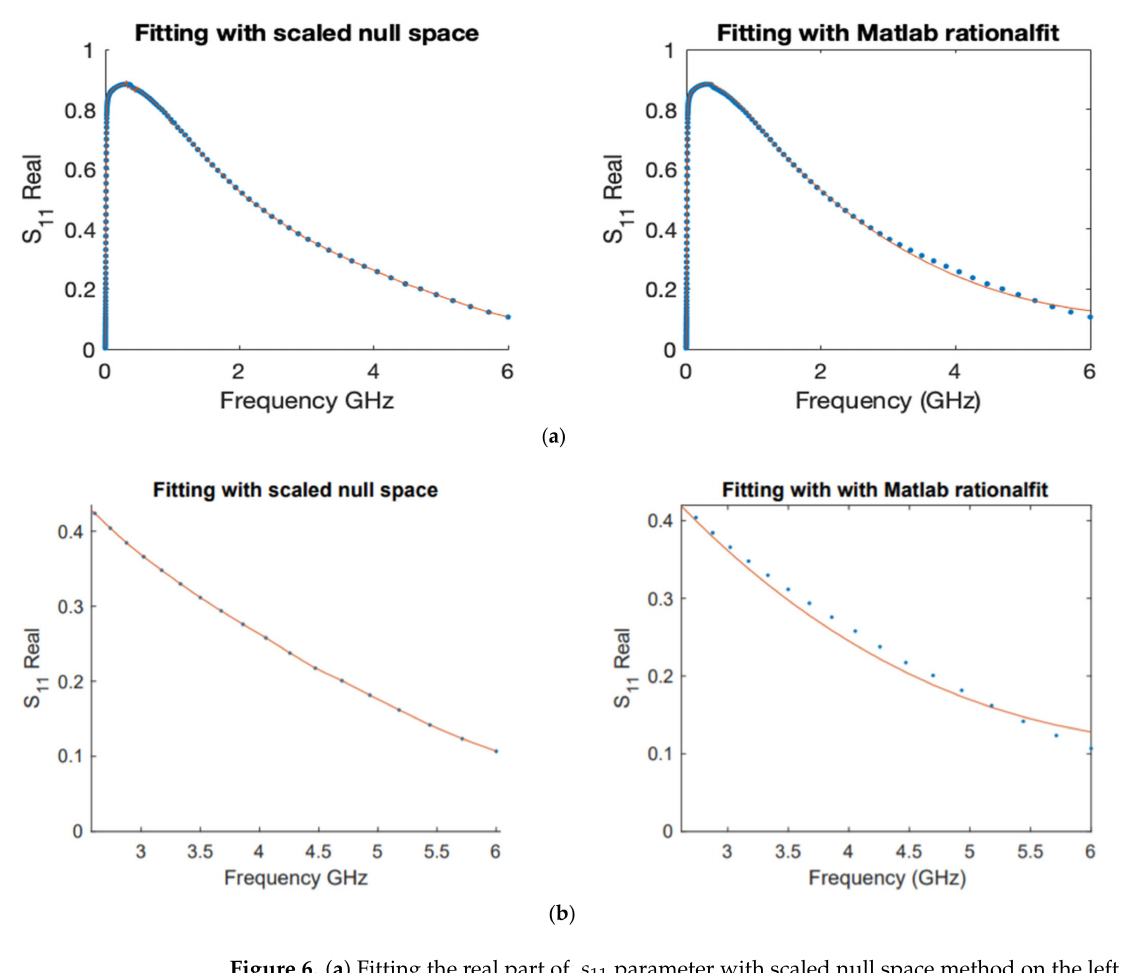
Figure 6. ( a ) Fitting the real part of s 11 parameter with scaled null space method on the left and with Matlab rationalfit on the right. Number of measurement data ( s , Re( s 11 )) is m = 202. We observe higher accuracy in fitting with scaled null space method. ( b ) We magnified ( a ) to show differences between two methods.